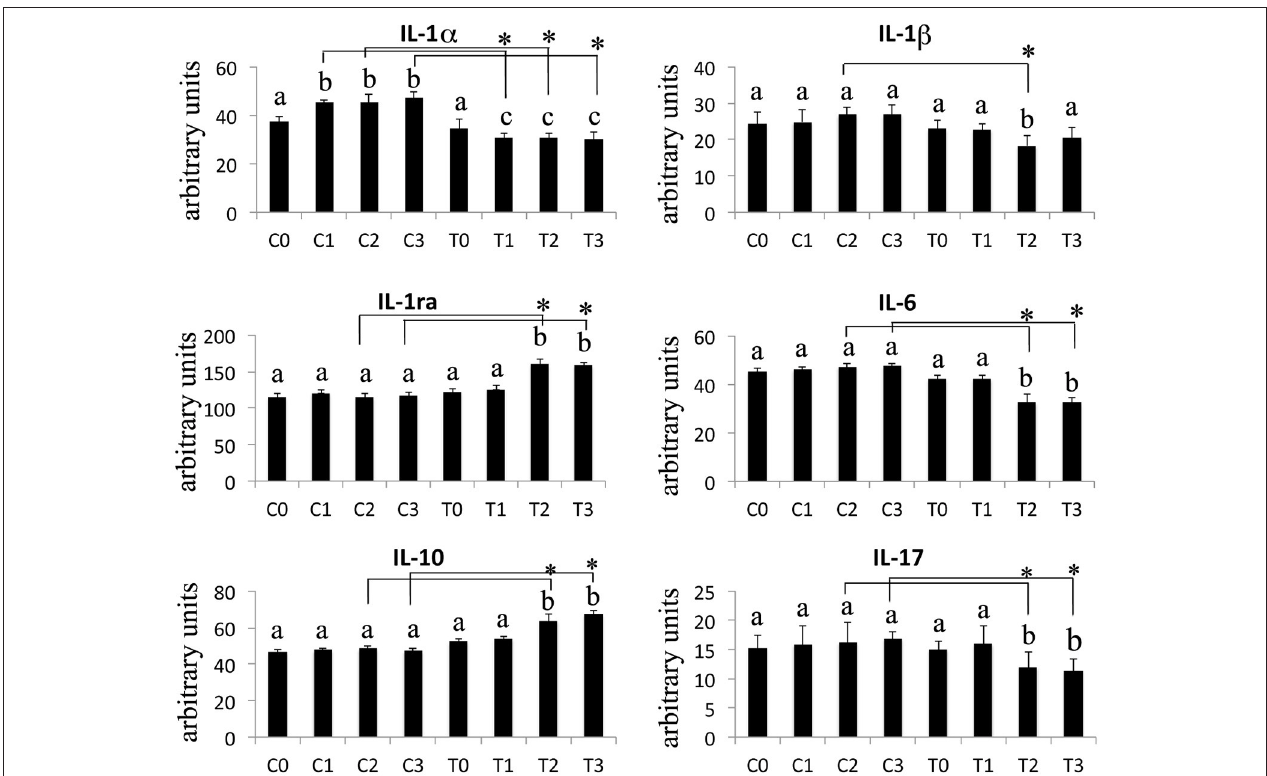
FIGURE 5 | Effects of laser irradiation on cytokines and chemokines release. Cells were laser irradiated over different period of time (Day 0: T0; 5 days: T1; 10 days: T2; 15 days: T3). Control cultures (Day 0: C0; 5 days: C1; 10 days: C2; 15 days: C3) were maintained in identical conditions except that the laser device was switched off. At the end of each treatment cytokines and chemokines were analyzed in medium from BMSCs laser irradiated or untreated. Graphic represents results of three independent experiments. Data were analyzed by using one-way ANOVA. Lowercase letters denote homogeneous subsets. Error bars represent ± SE (* p <